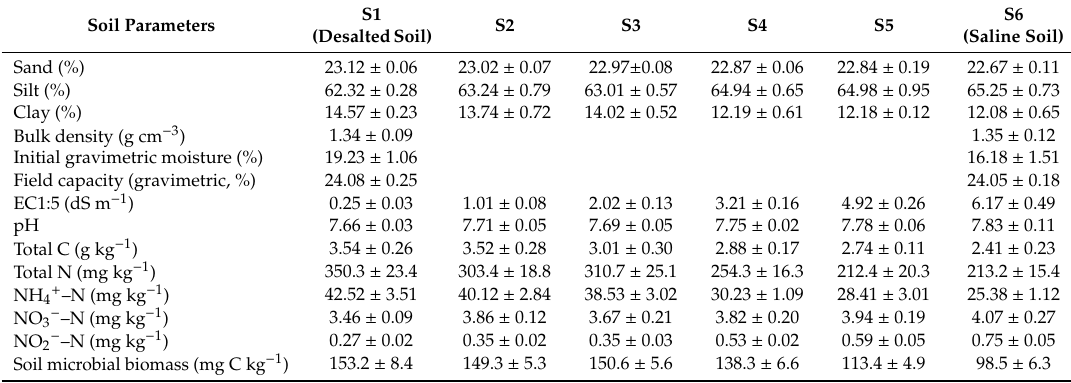
Table 1. Properties of desalted soil (S1), saline soil (S6) and mixed soils (S2, S3, S4 and S5) at the beginning of the